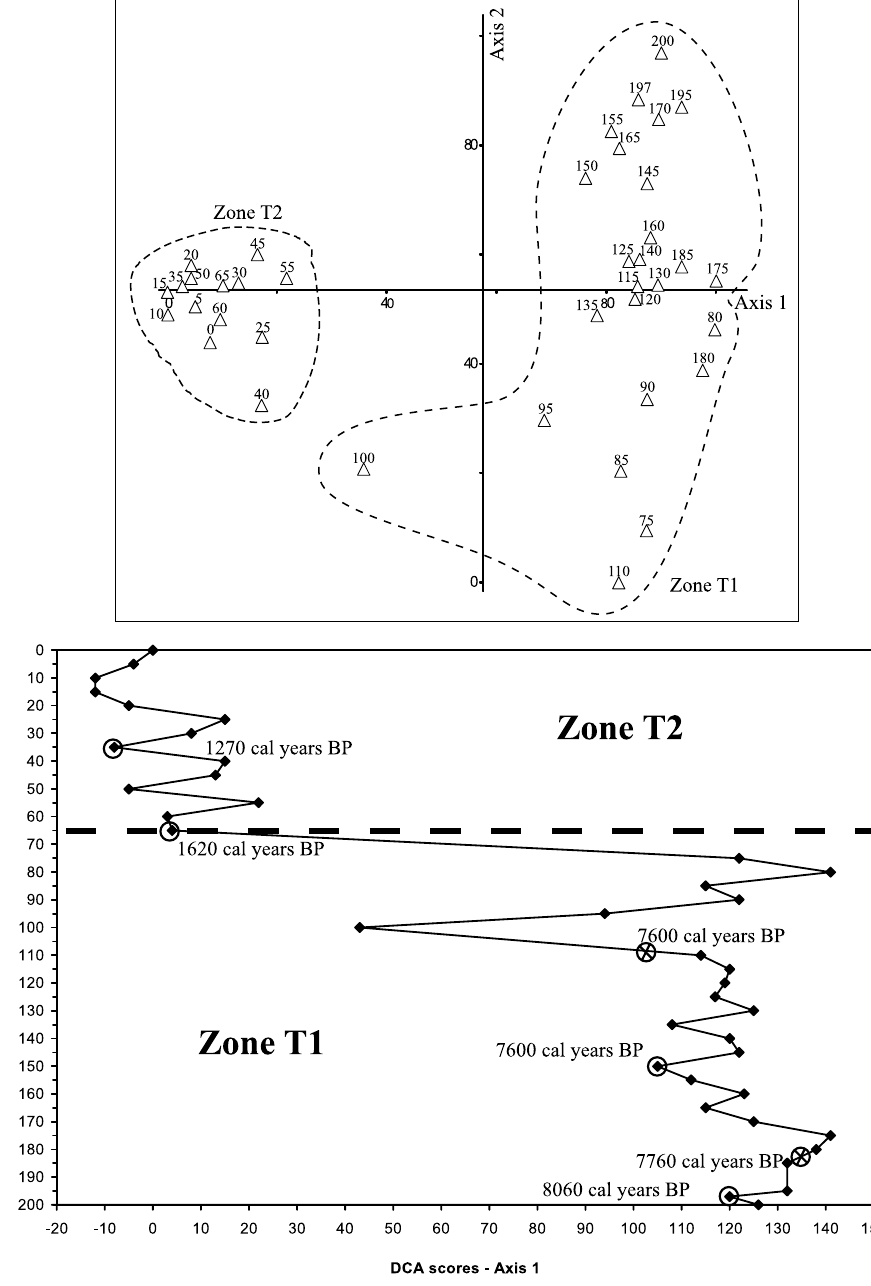
Fig. 5 – DCA scores from Lake Tapera. Top graph shows axis 1 vs. axis 2. Samples are encircled to display zones as interpreted from pollen diagrams. Bottom graph represents resulting DCA scores of axis 1 plotted vs. depth (cm) showing a strong polarization of samples into two main groups representing zones T1 and T2. Ages obtained from C 14 AMS are also